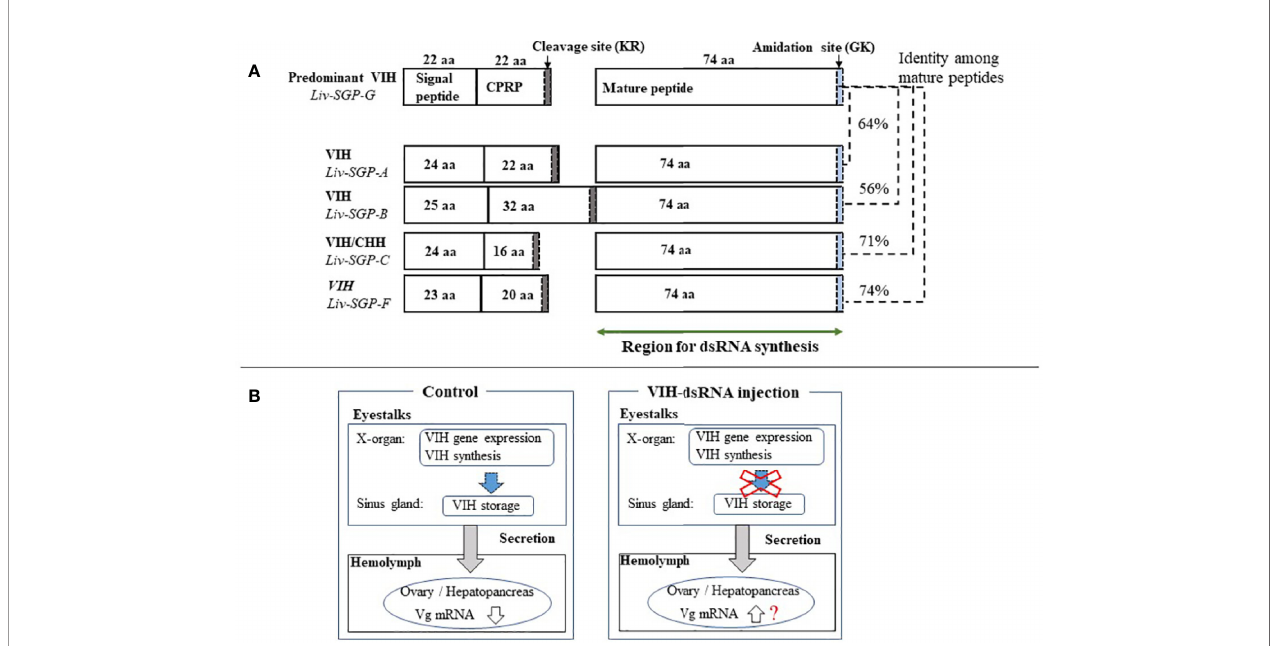
FIGURE 6 | (A) Schematic representation of the molecular structure of VIH subtype I peptides in L. vannamei . Genetic information for all VIH subtype I peptides ( Liv- SGP-A , -B , -C , -F , and -G ) from our previous study was used to construct the drawing (18). The number of amino acid residues (aa) for each corresponding region is shown within each box or above the box in the case of Liv-SGP-G . Respective parts are shown as signal peptides, CPRP (CHH precursor-related peptide), and mature peptides. Cleavage sites are indicated by gray shading. Amidation sites are indicated by blue shading. The target region for dsRNA synthesis is indicated by a green arrow. Identity between amino acid sequences corresponding to mature peptide are shown in terms of percentage. (B) Schematic representation of VIH regulation on ovarian maturation. VIH that is synthesized and secreted from the eyestalks is thought to fl uctuate, thus alternatively suppressing ovarian maturation and allowing it to proceed in nature. Therefore, the suppression of VIH synthesis could be arti fi cially lifted by transcriptional silencing, thus promoting ovarian maturation; however, the knockdown of vih transcription alone cannot induce oocyte